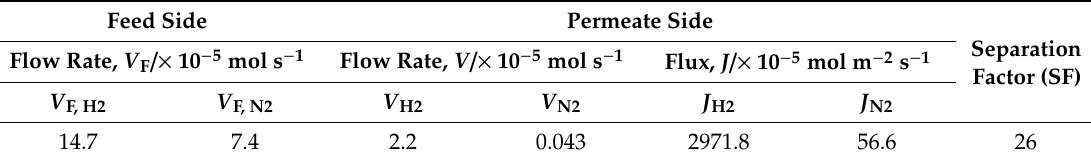
Table 2. Gas permeation data of 500 °C-synthesized membrane further modified with PCS measured at 50 °C under p/p 0 (H 2 O) =1.0 using a H 2 -N 2 (2:1) mixed feed gas.